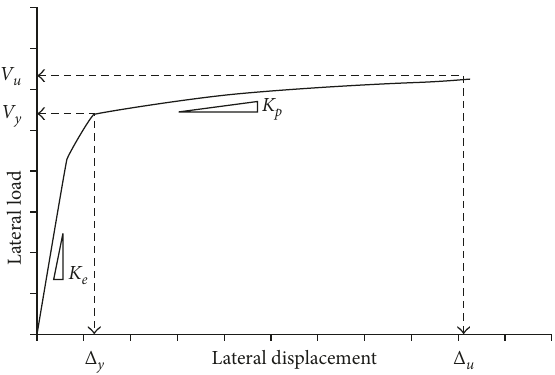
Figure 5: Main parameters of load deflection curve.